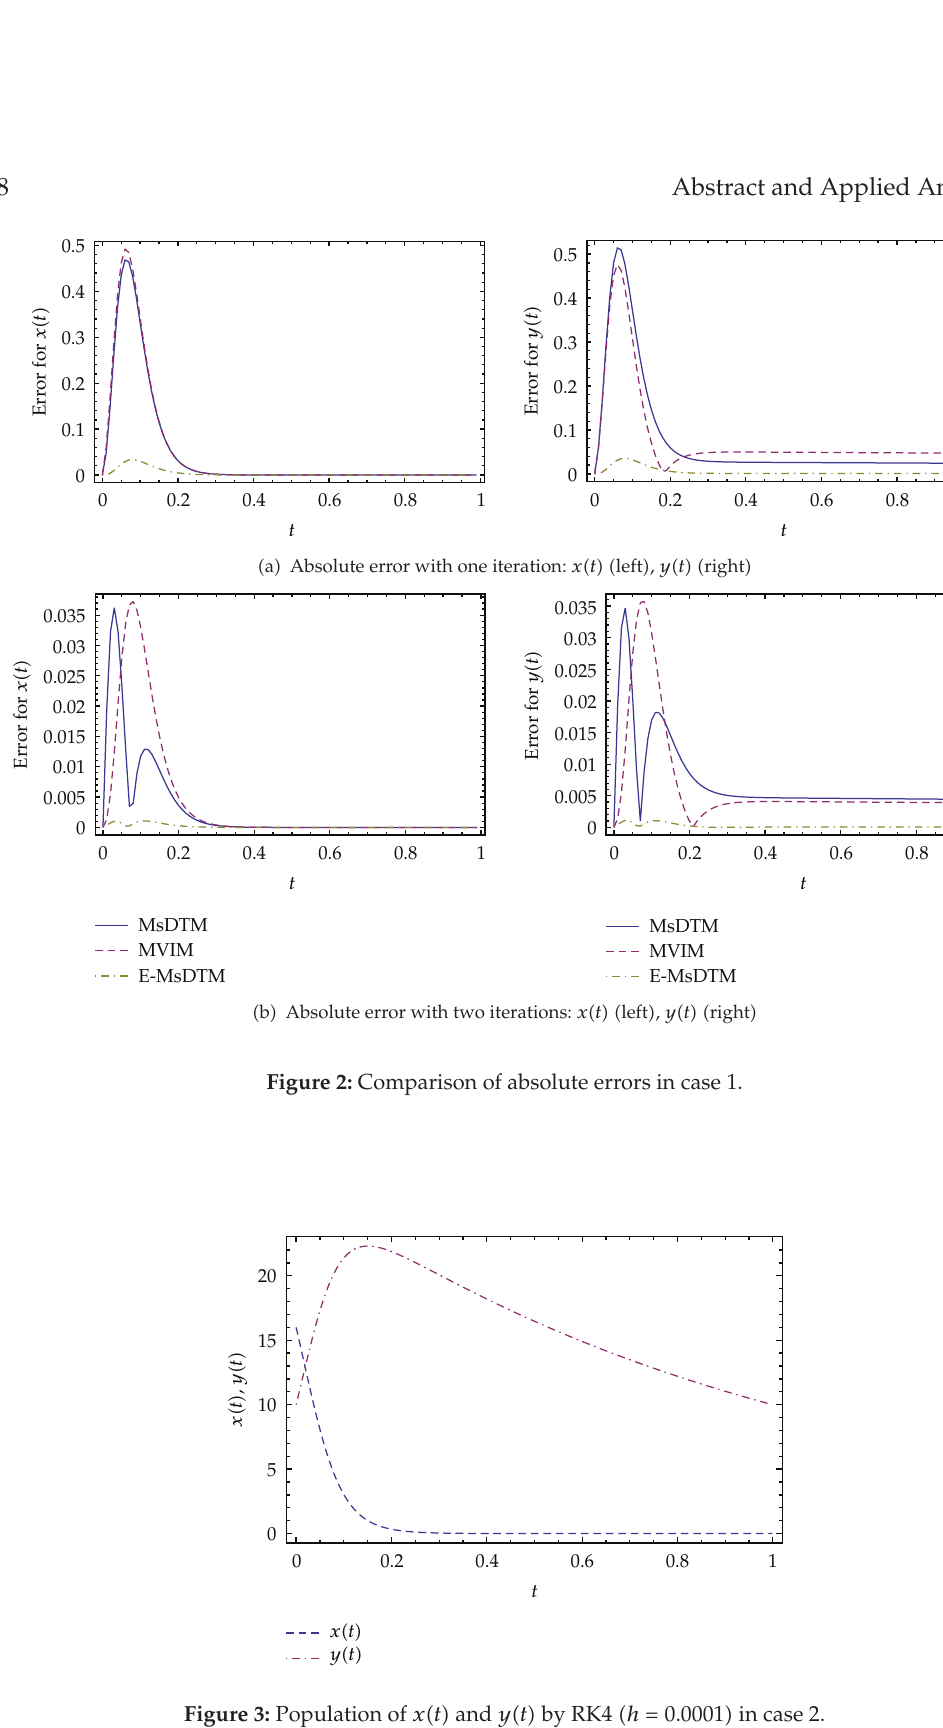
Figure 3: Population of x (cid:4) t (cid:5) and y (cid:4) t (cid:5) by RK4 (cid:4) h (cid:8) 0 . 0001 (cid:5) in case